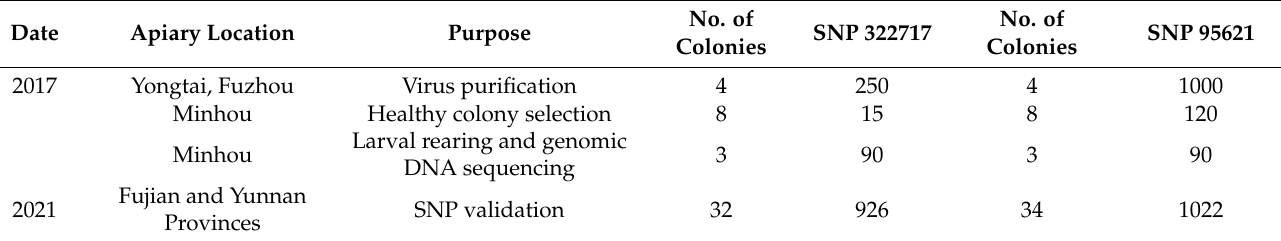
Table 4. Experimental colony details used in this